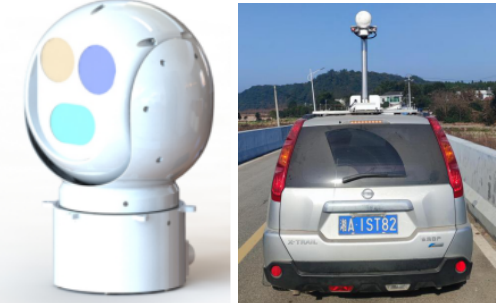
Figure 33. Equipment used in the experiment: ( Left ) Camera can be rotated and images are captured by command; and ( Right ) installation of the camera on the experimental vehicle.